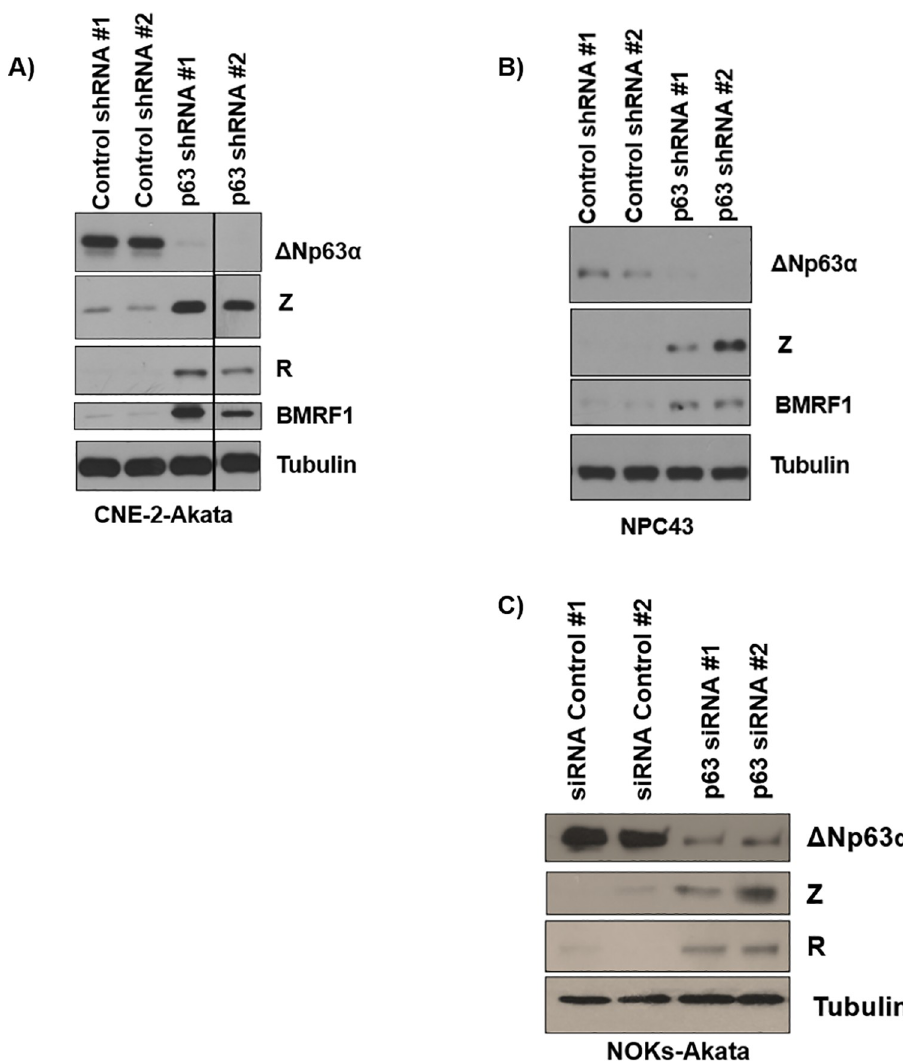
Fig 2. Δ Np63 α depletion results in EBV lytic reactivation in EBV+ carcinomas (CNE-2 and NPC43) and telomerase-immortalized oral keratinocyte (NOKs) cell lines. A) CNE-2-Akata cells were infected with lentiviruses expressing shRNAs against p63 or a control sequence, selected with puromycin, and harvested for immunoblot analyses to measure expression levels of the EBV Z, R, and BMRF1 lytic proteins, Δ Np63 α , and tubulin proteins as indicated. B ) NPC43 cells were infected with lentiviruses expressing shRNAs that target p63, or a control sequence. Two days post-infection, cells were harvested for immunoblot analysis to assess the expression of Z, BMRF1, Δ Np63 α , and the loading control tubulin. C) NOKs-Akata cells were transfected with siRNAs against p63 or a control siRNA. Two days after transfection, the cells were harvested for immunoblot analyses and expression of the Z, R, Δ Np63 α and tubulin proteins was examined as indicated. The black line indicates where irrelevant lane(s) were removed. The original western blots used to construct this figure are shown in supplemental Fig 1. All figures shown are representative of eight independent biological